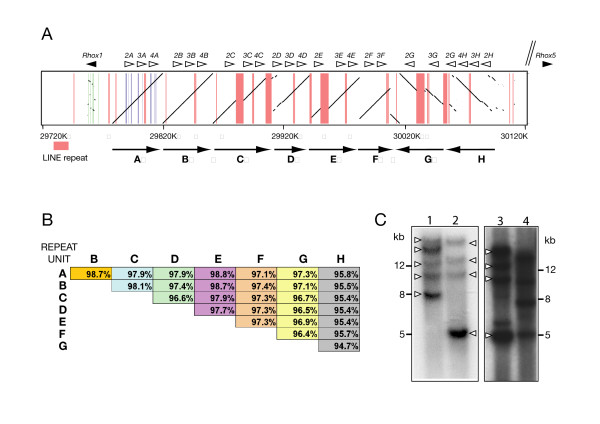
A. Dotplot analysis comparing repeat A to repeats B to H using the NCBI m33 mouse assembly (freeze May 27, 2004, strain C57BL/6J). Black lines represent regions of identity interspersed with LINEs (horizontal pink lines). The orientation and approximate size of each repeat unit is presented as black arrows. The relative position and orientation of Rhox1 (green lines, black arrowhead) and Rhox2, 3 and 4 (blue lines, white arrowhead) and Rhox5 (which is upstream of this region, black arrowhead) are shown. The X chromosome co-ordinates are provided below the dotplot. B. BLAST analysis comparing genomic sequence of each repeat to all others. LINE repeats and rearrangements were not added. Top row represents a comparison of repeat A to B-H, second row repeat B to C-H and so on. C. Southern Blot analysis. CGR8 ES cell genomic DNA digested with Asp718 (lane 1) and HindIII (lane2) and hybridised to Rhox4 exon 1 and intron 1 probe. Multiple bands can be seen with both digests (arrowed) of approximately 20, 13, 10 and 5 kb (HindIII) and 23, 18, 13, 10, and 8 kb (Asp718). Mus domesticus (lane 3) and Mus spretus (lane 4) genomic DNA digested with HindIII and hybridised to a Rhox4 exon 2 probe. Fragment sizes common to the Mus musculus (ES cells) and Mus domesticus are arrowed. Additional bands are predicted to be due to the differences between the probes used. Positions of size standards are provided in kilobases.